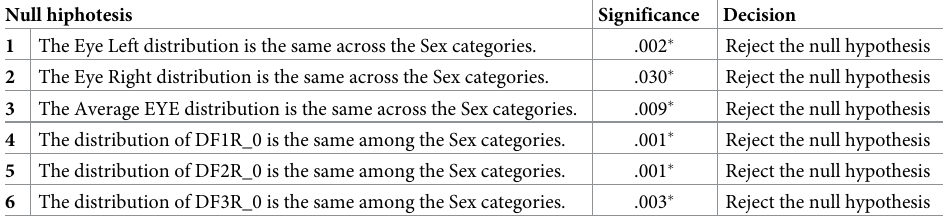
Table 2. Mann-Whitney U test—Variables and ROIs.